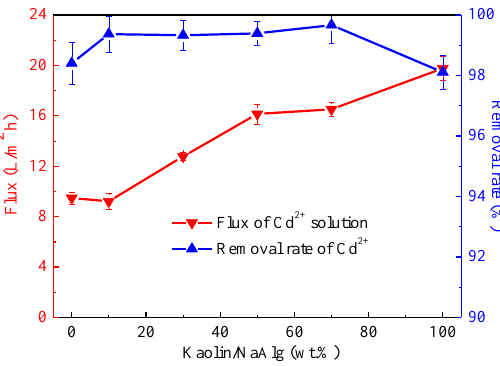
Figure 9. The effect of kaolin content on the flux and removal rate of Cd 2+ .